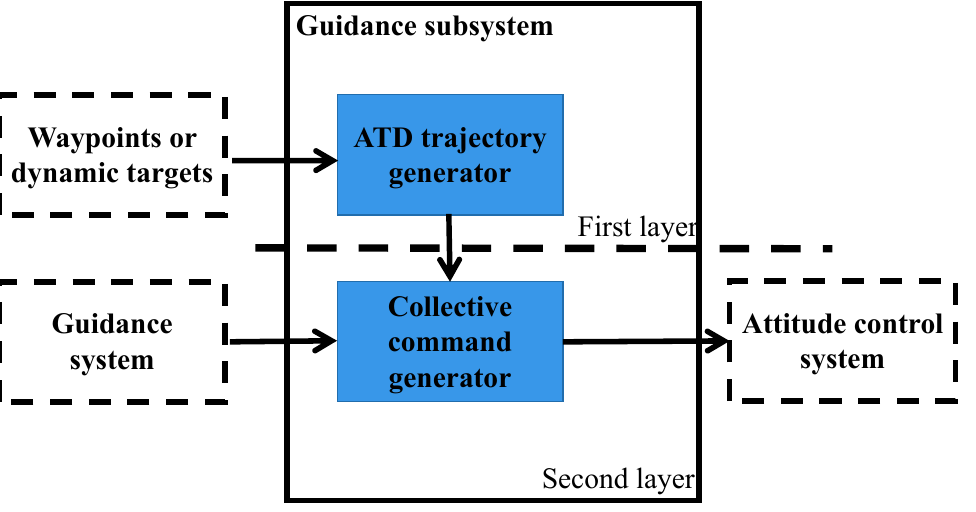
Figure 1. Diagram of guidance subsystem.